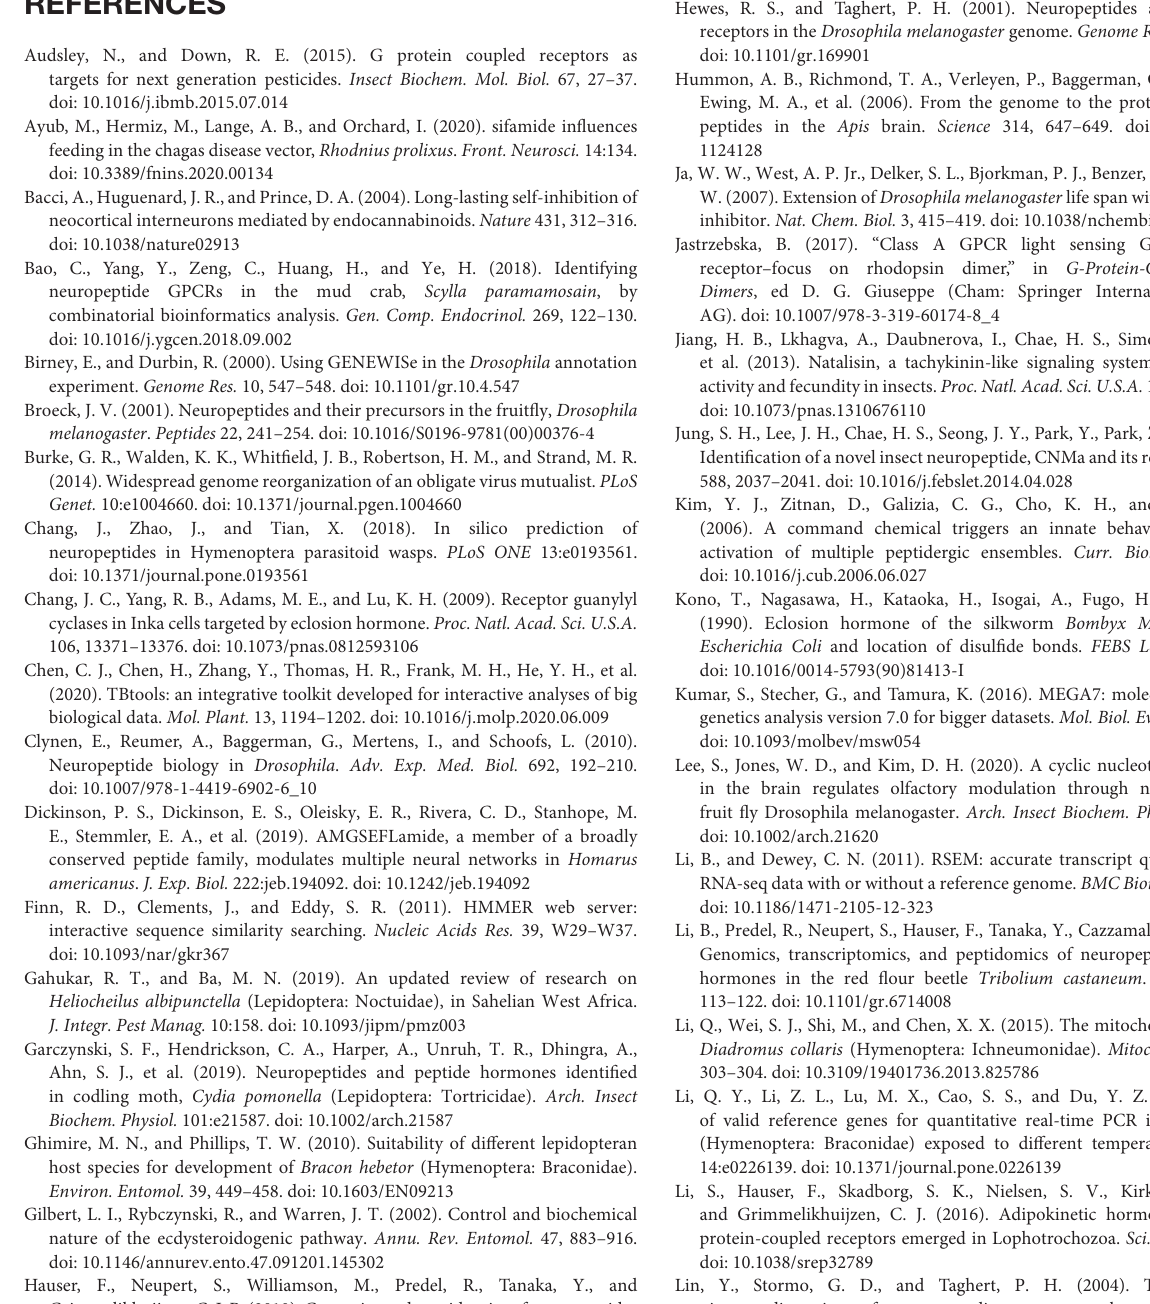
Supplementary Figure 2 | Expression profiles of neuropeptide precursor receptor genes in H. Hebetor across its different tissues. Log2 FPKM (fragments per kilobase of transcript per million) values for neuropeptide precursor genes are presented by bar colors where darker red denotes higher expression values, and darker blue denotes lower expression values. VG, venom glands; SG, salivary glands; VGC, carcass of female adults without their venom gland; SGC, carcass of larvae without salivary glands.